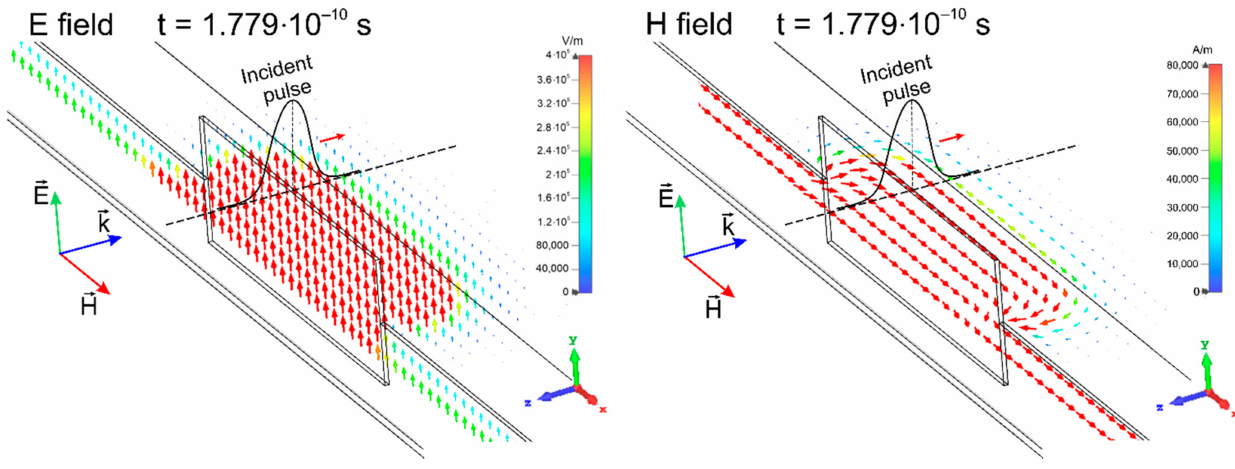
→ → Figure 9. Associated electric E and magnetic H fields shown separately at t = 0.1779 ns (i.e., when the incident pulse maximum passed the enclosure front wall plane). The primary wave P1 was not yet fully developed (the phase just → k shows the propagation direction of the incident pulse. Retrieved from before the detachment from the aperture). Vector Figure